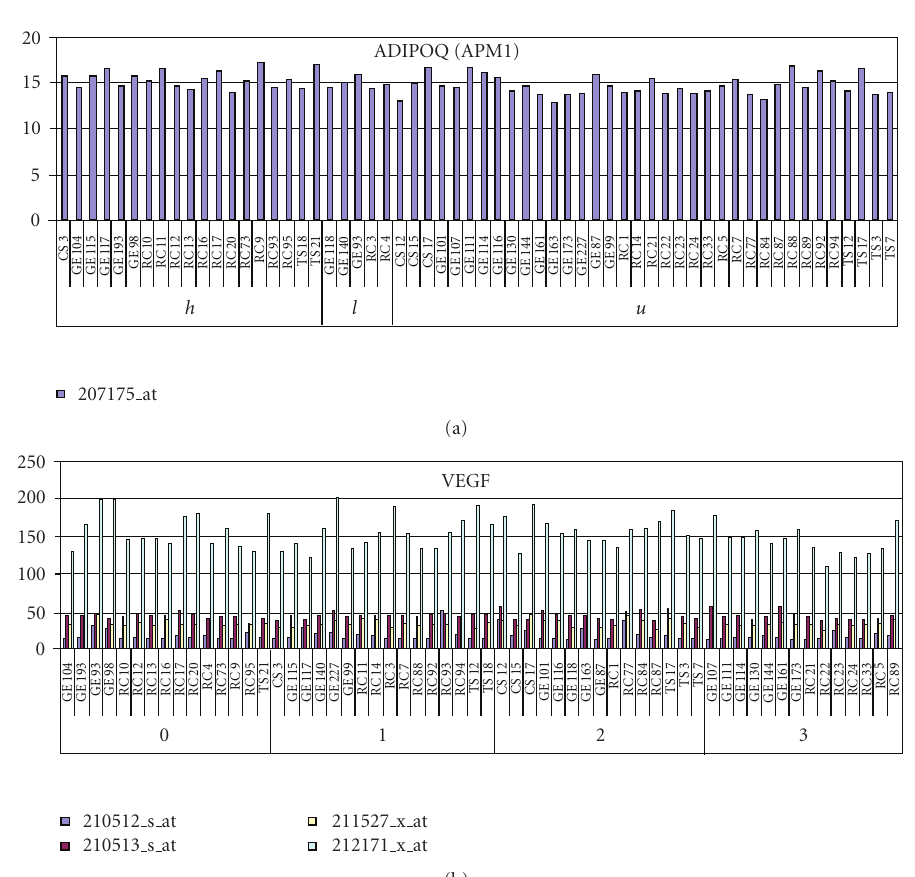
Figure 3: Absolute RMA intensity values for adiponectin (ADIOQ) (a) and VEGF (b) transcript in 60 B-CLL patients assessed by microarray